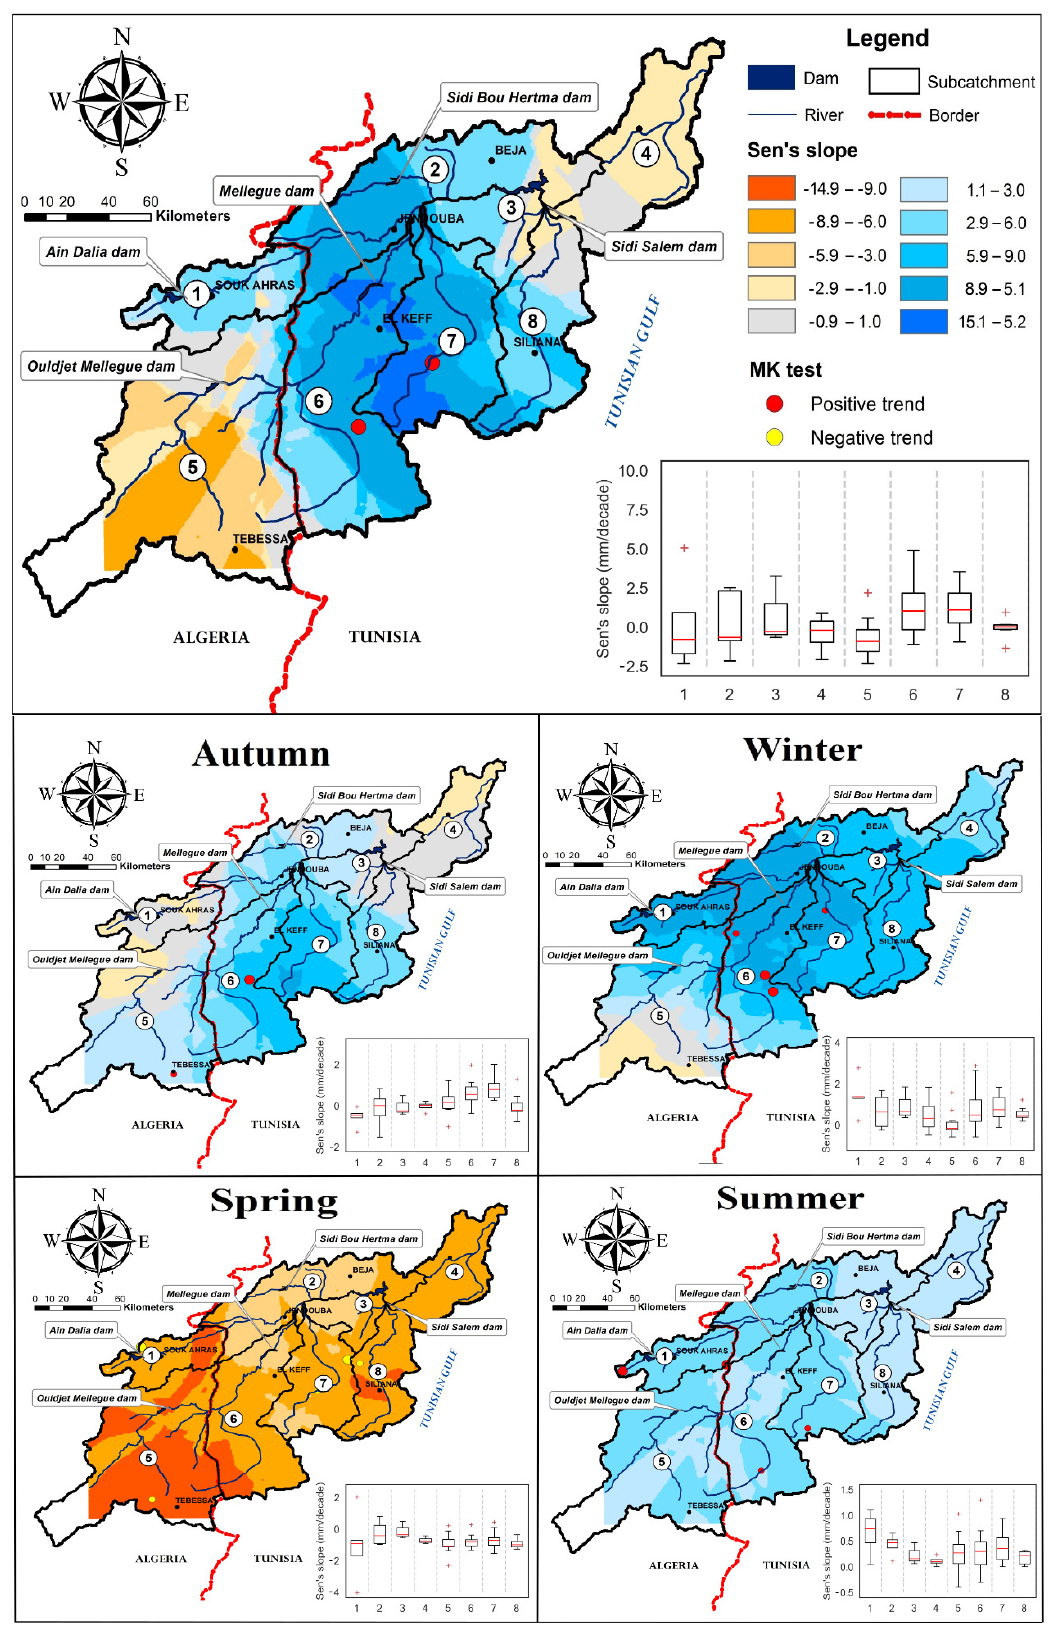
Figure 7. Spatial distribution of Sen’s slope and MK trend over the Medjerda Watershed at annual, seasonal scales. Red and yellow circles dimensions are related to MK significance level. Box plots represent the Sen’s slope (mm/decade) for each subcatchment.